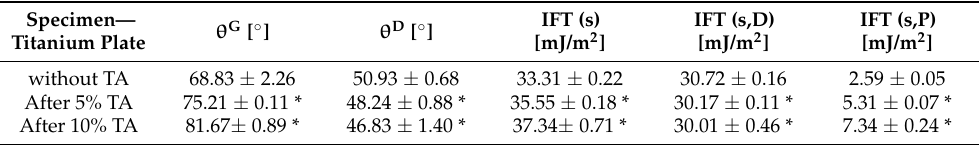
Table 1. Contact angle for glycerin ( θ G ), diiodomethane ( θ I ) and surface free energy (IFT (s)) and its polar (IFT (s,D)) and dispersion (IFT (s,D)) components for the TA deposited on the surface of the titanium plate (n = 5; * significantly different from plates without TA— p < 0.05). Moreover, the blood compatibility of obtained materials was